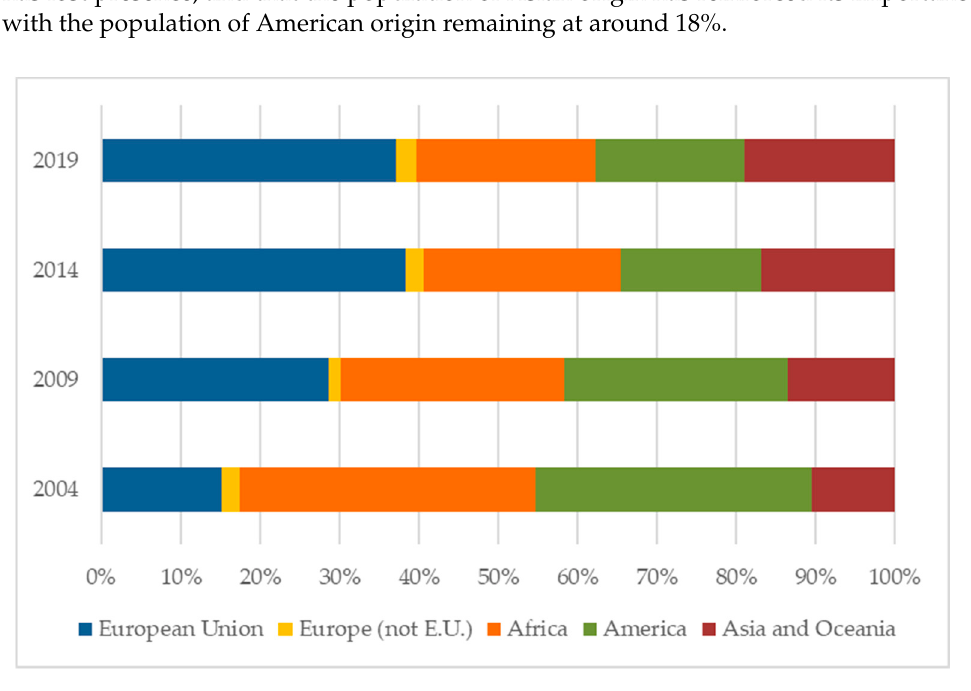
Foreign- ers Total Annual Growth Rate for Span- iards (%) Annual Census Growth Rate for For- eigners (%) 2004